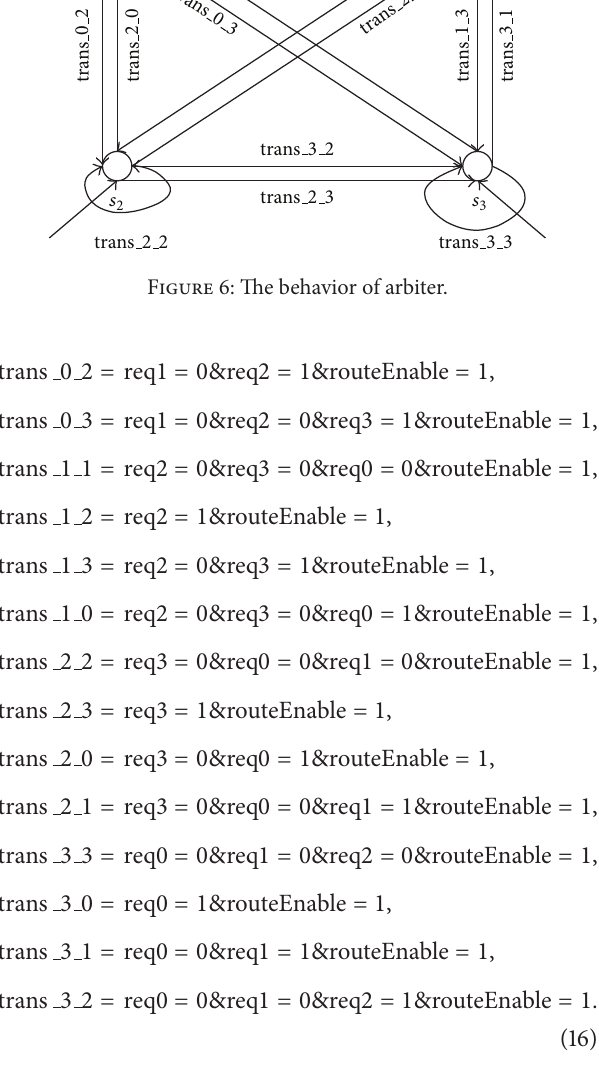
Figure 4: The resulting assertion graph 𝐺 󸀠 .